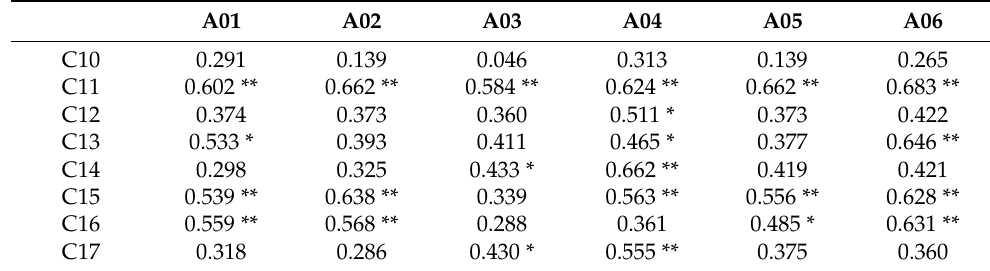
Table 2. Spearman correlation analysis between management and equipment.